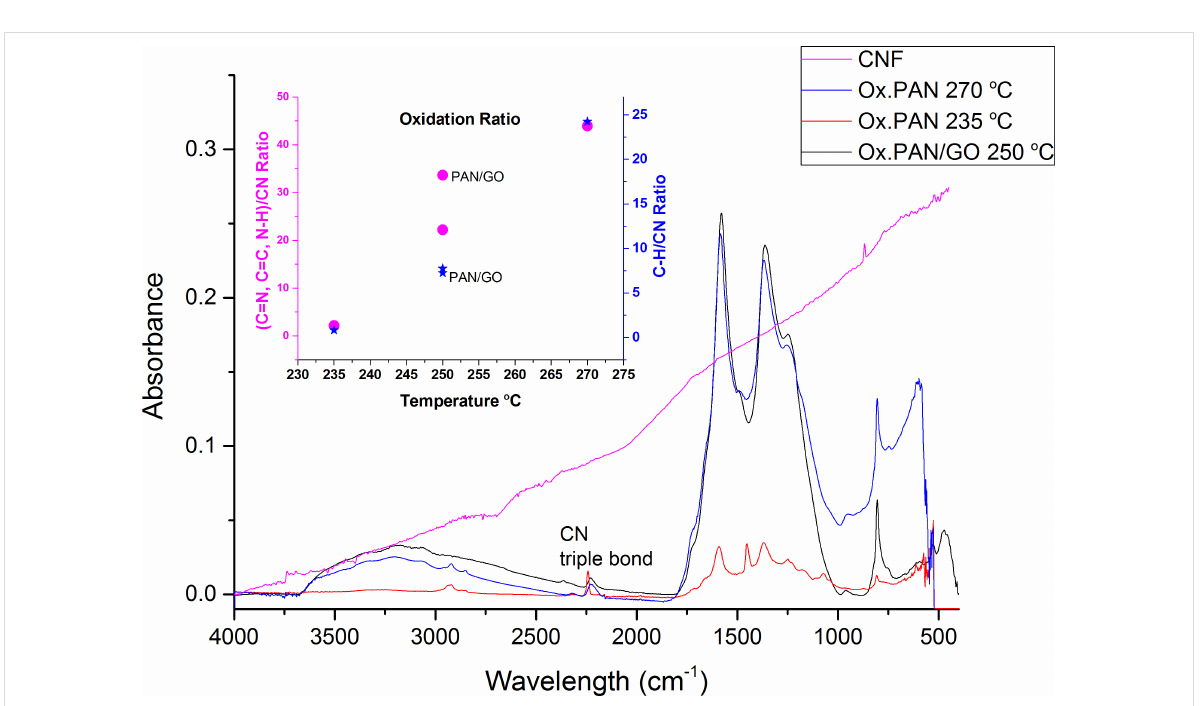
Figure 4: ATR-FTIR results of oxidized webs with GO and of the carbon nanofiber web. The inset represents the oxidation ratio of the webs as a function of the temperature according to absorbance ratios of (C=N, C=C, N–H)/C ≡ N and the newly occurred =C − H/C ≡ N ratio. (C=N, C=C, N–H) represents the mixture of the corresponding